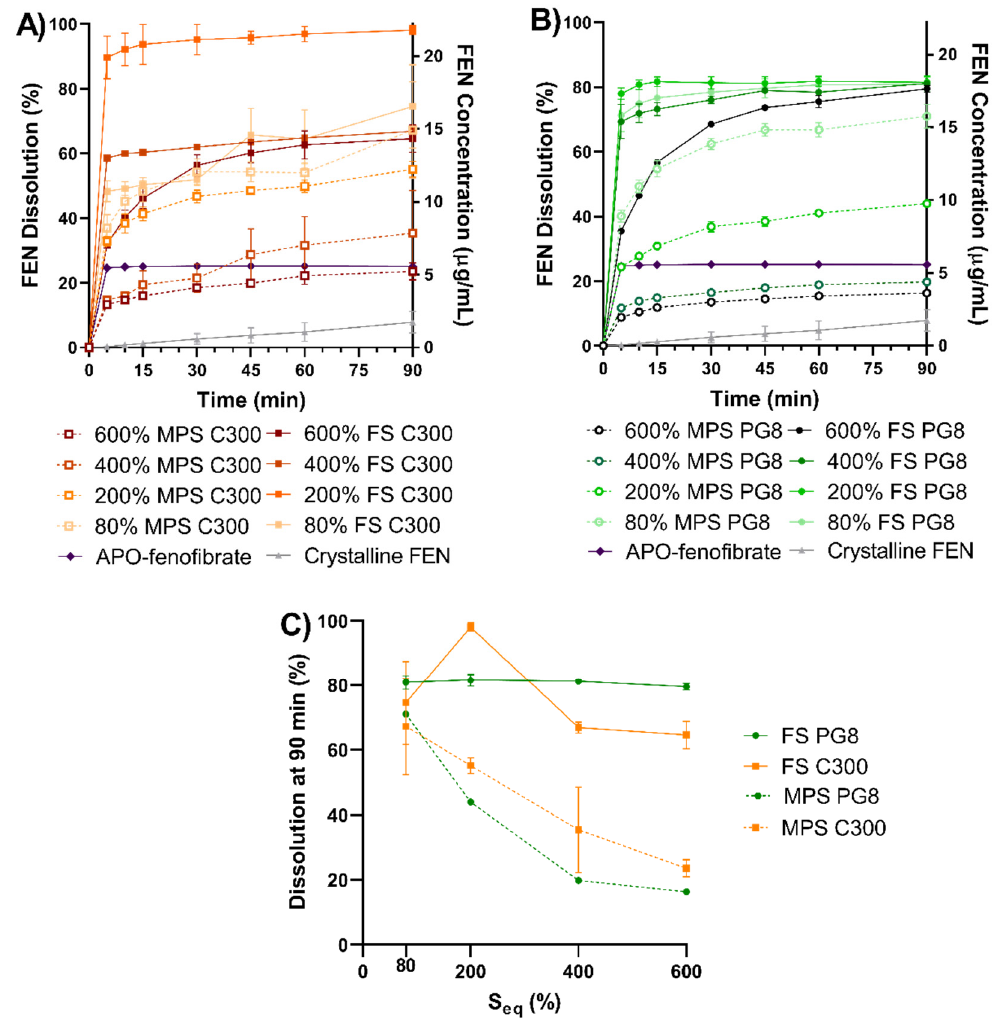
Figure 5. The in vitro dissolution profiles of crystalline FEN, APO-fenofibrate and FEN-loaded SLH formulations (at different saturation levels) in 0.0125 M SLS, dosed at 10 mg of FEN over 90 min at sink conditions. (mean ± SD, n = 3). ( A ) SLH C300 formulations, ( B ) SLH PG8 formulations, and ( C ) FEN % dissolution at 90 min vs % S eq .